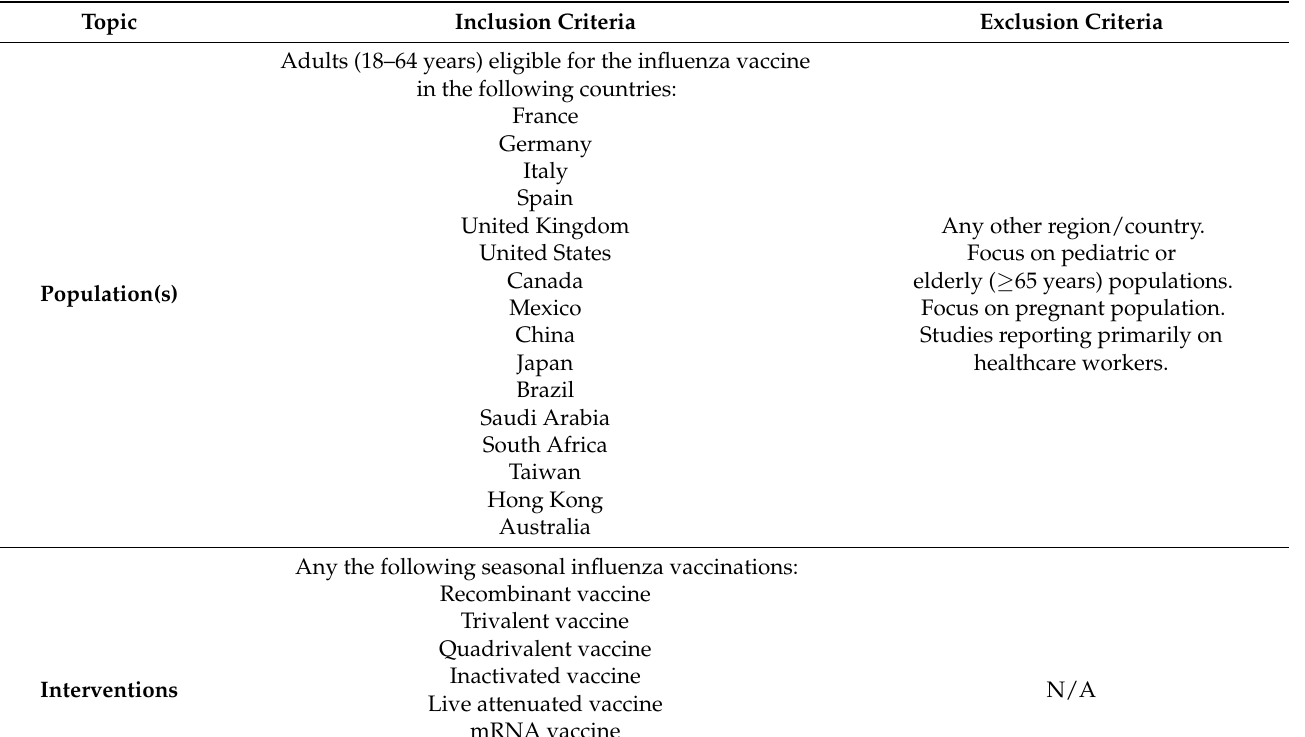
Table 1. Eligibility